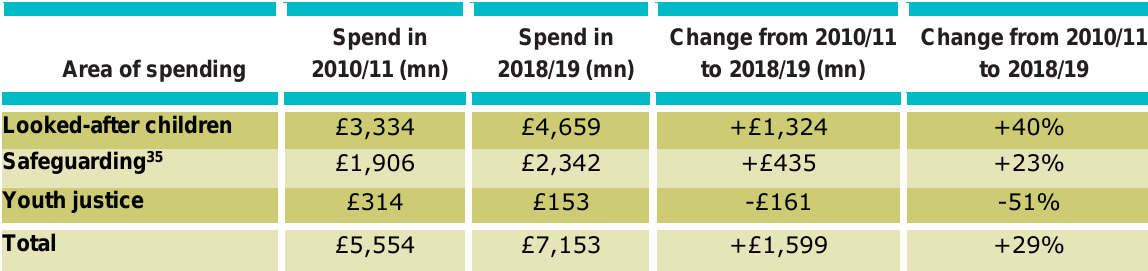
Table 6: Local authority spend on late intervention services in real terms 34